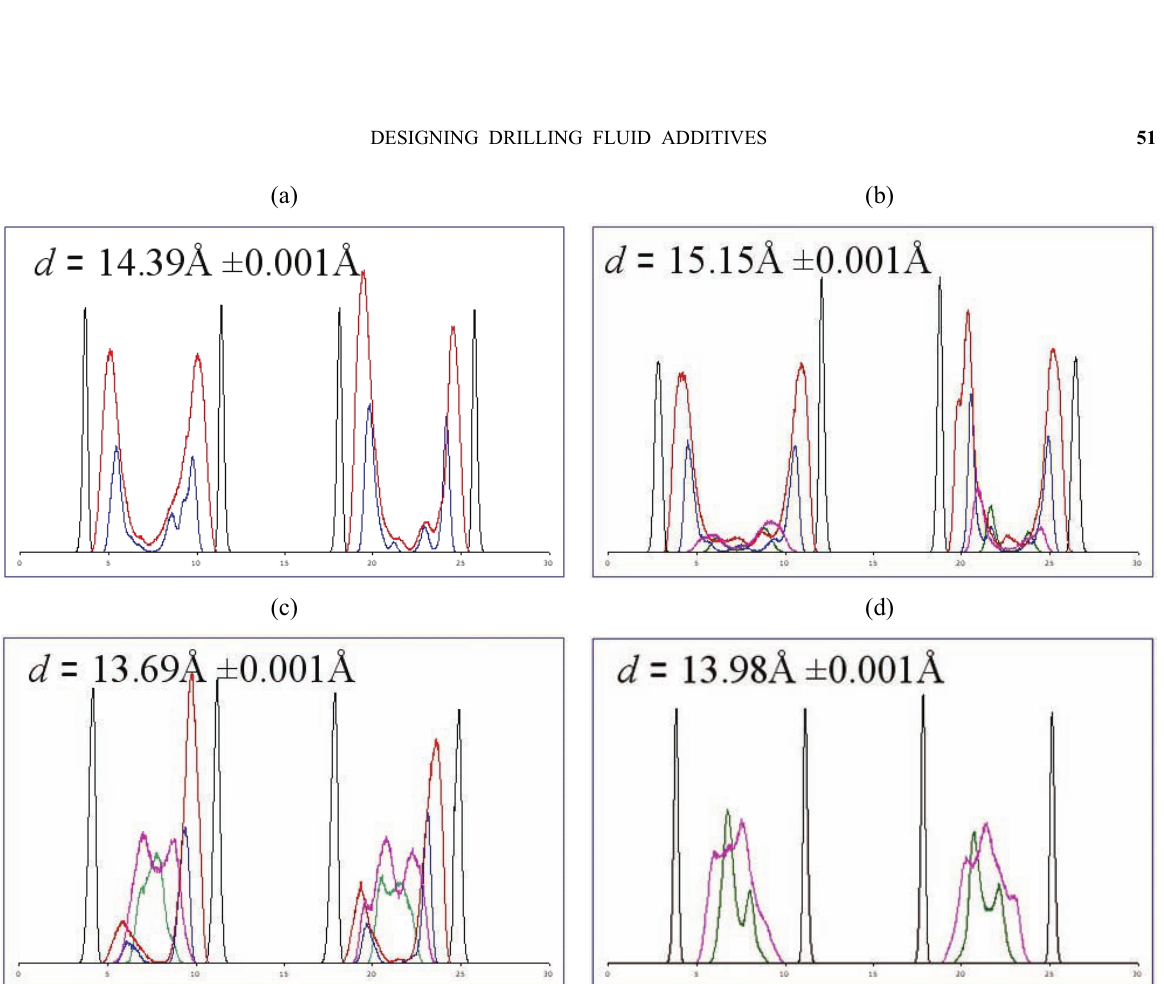
Fig. 3 – One-dimensional atom density maps for interlayer species in MD simulations of, (a) poly(propylene oxide) diammonium (PPO– NH + 3 ); (b) poly(propylene oxide) 66% mix (PPO–NH 2 /PPO–NH + 3 ); (c) poly(propylene oxide) 33% mix (PPO–NH 2 /PPO–NH + 3 ) composites; (d) poly(propylene oxide) diamine (PPO–NH 2 ) Na + -montmorillonite. Colours are as follows: Siloxane surface clay O atoms (black), ammo- nium N (blue), amine N (green), ammonium H (red), amine H